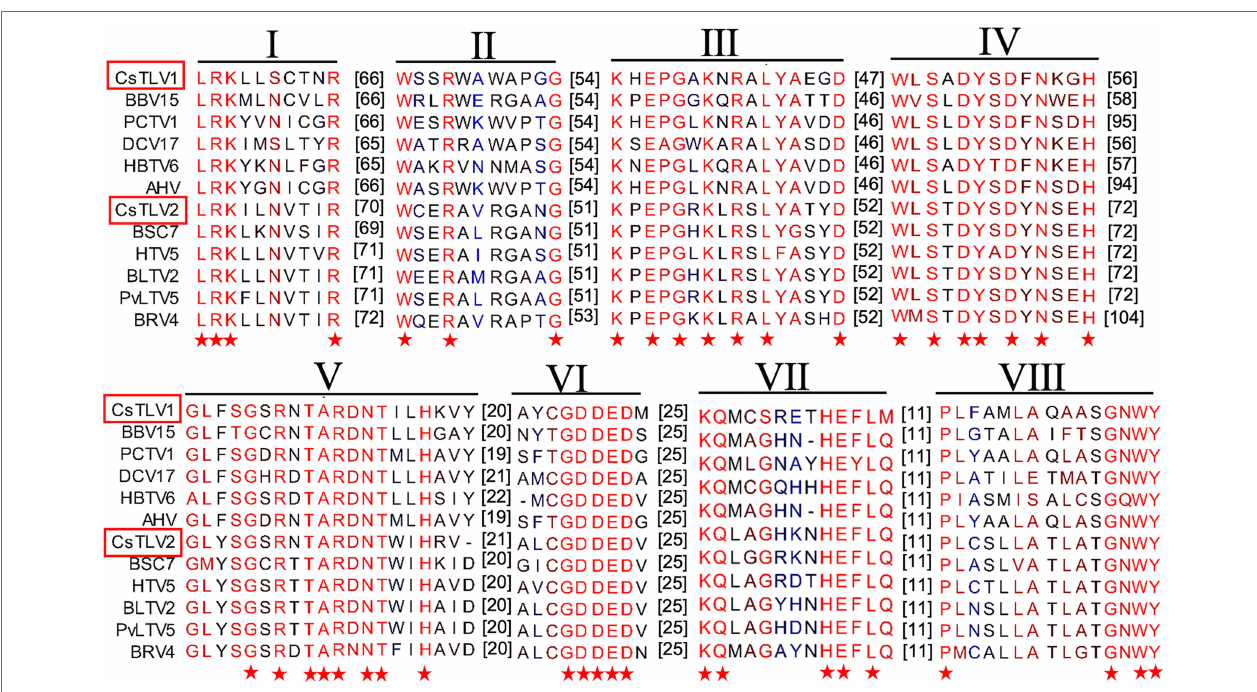
FIGURE 4 | Conserved motifs in RNA dependent RNA polymerase protein (RdRp) of CsTLV1 and CsTLV2. Amino acid sequences alignment of CsTLV1 and CsTLV2 with closely related toti-like viruses from NCBI database. Horizontal lines above the alignment indicate the eight motifs, numbers in brackets indicate the amino acid sequence lengths between the motifs, asterisks indicate identical amino acid residues, and color gradients indicate the similarity level of amino acid residues. Virus notations are as in Supplementary Table 2